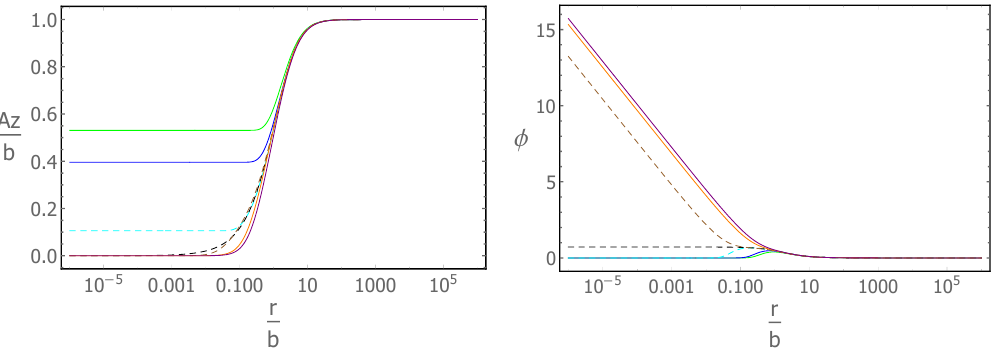
Figure 1 . The bulk pro(cid:12)les of A z and (cid:30) for di(cid:11)erent values of M=b = 0 : 941 (green), 0 : 983 (blue), 0 : 987 (dashed cyan), 0 : 986 (dashed black), 0 : 984 (dashed brown), 0 : 987 (orange), 1 : 019 (purple). The solid lines are pro(cid:12)les in the stable phase while dashed lines are for the unstable phase.